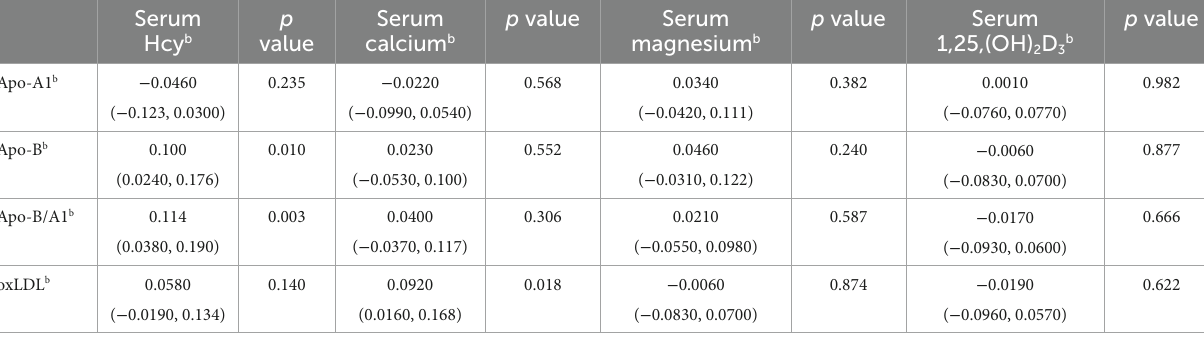
TABLE 4 Associations of serum Hcy and calcium, magnesium, 1,25,(OH) 2 D 3 with biomarkers of cardiovascular disease in children. a